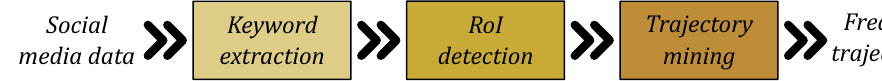
Figure 1. Execution flow of Frequent Trajectory Mining using